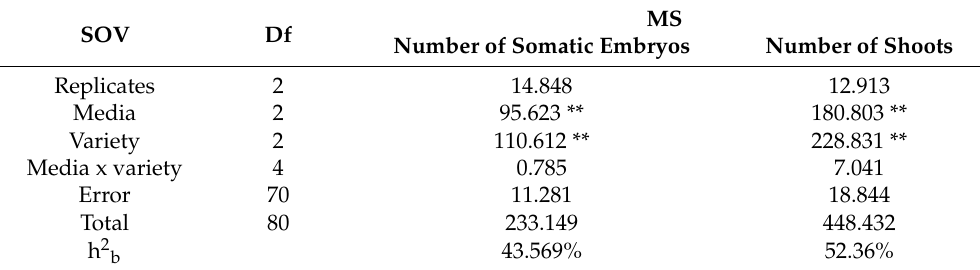
Figure 5. ( A ). The callus weights of the three maturation media (MM1, MM2 and MM3). ( B ). The callus weights of the three varieties (Amri, Magdoul and Barhy). Note: Charts with the same letter are not statistically different at p < 0.05. Different letters denote a significant difference among culture media at p < 0.05. Table 2. Mean sum of squares (MS) of the number of somatic embryos and the shoot number in Amri, Barhy and Magdoul